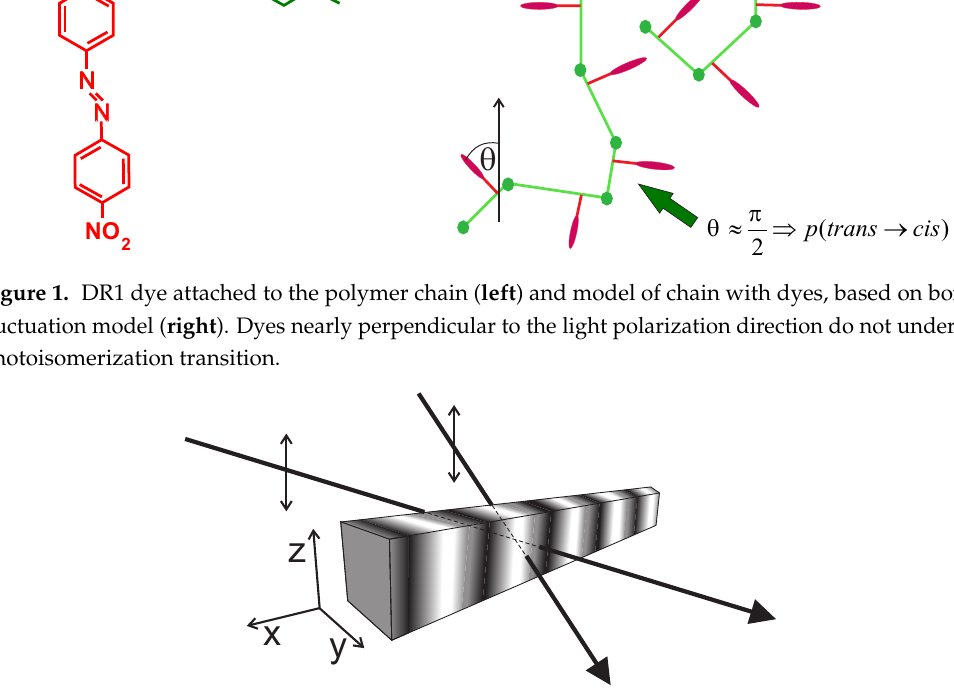
Figure 2. Illumination setup for Degenerated Two Wave Mixing inscription (DTWM) of